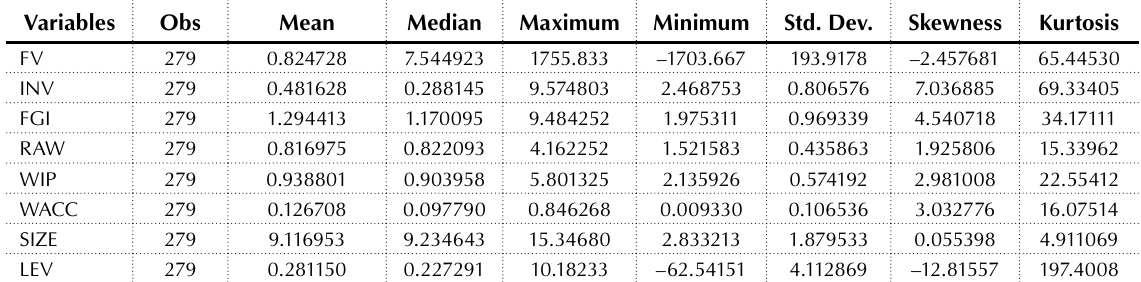
Table 3. Summary of